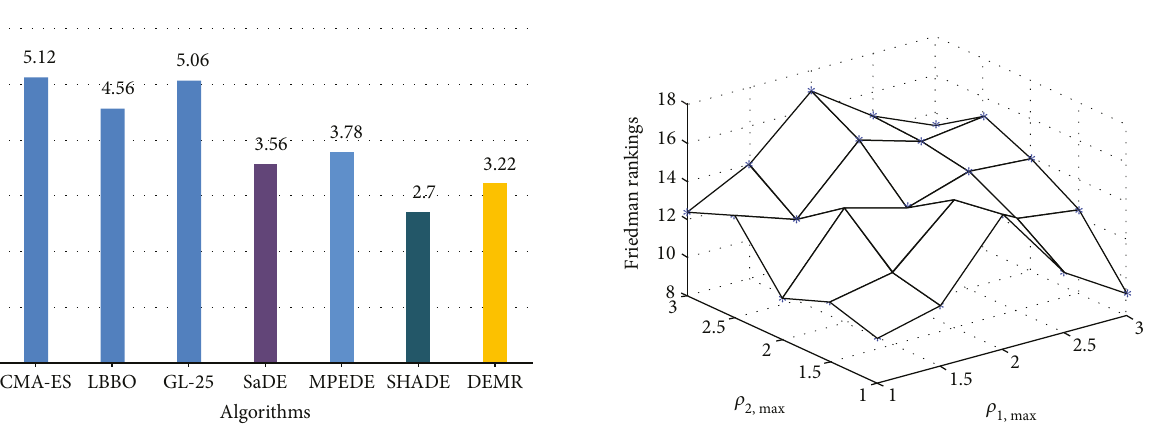
Figure 6: Average rankings for all algorithms on 25 benchmark functions.